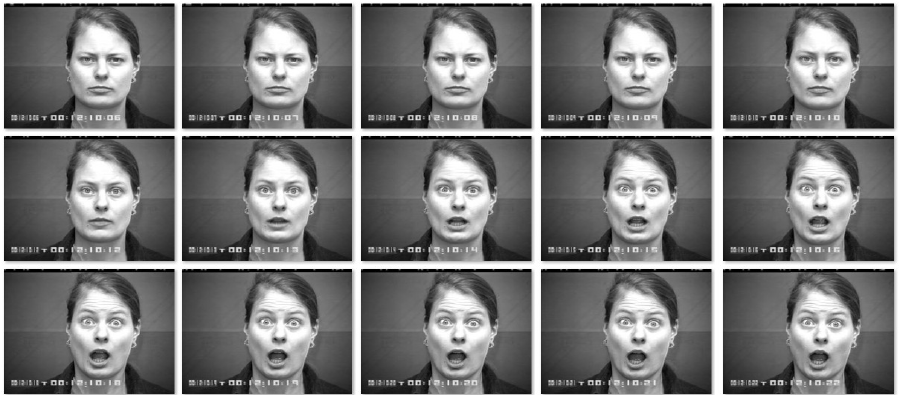
Figure 9. Some image samples from the CK+ database.